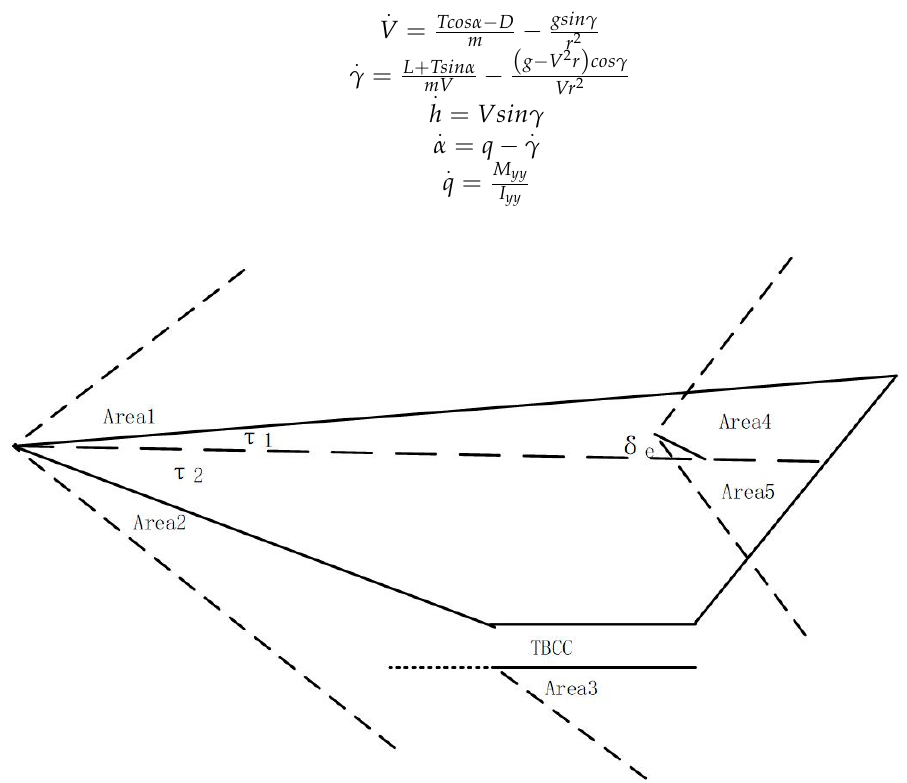
Figure 3. Schematic diagram of supersonic vehicle.